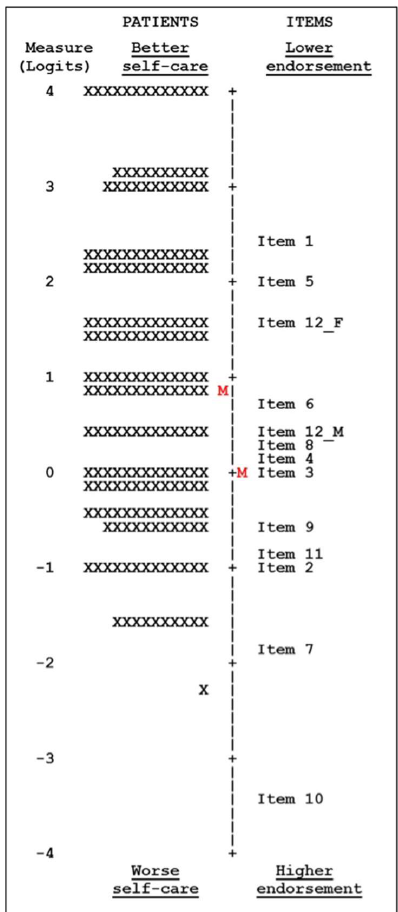
Figure 2. Map of items and persons. Each “X” represents 1 patient. Self-care and endorsement of items are measured in the same units. The “M’s” represents the mean level of self-care on the patients’ side and the endorsement location on the items’ side .